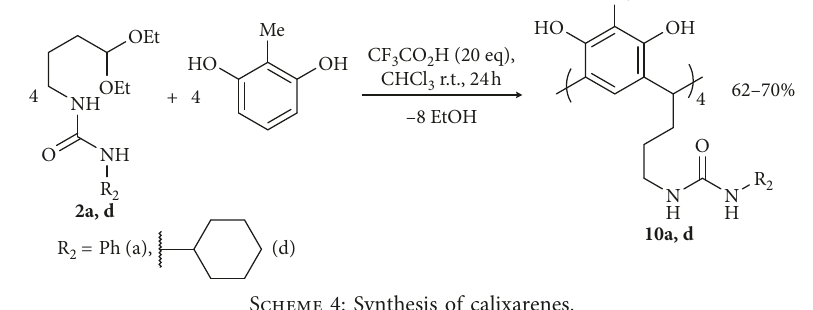
Scheme 4: Synthesis of calixarenes.